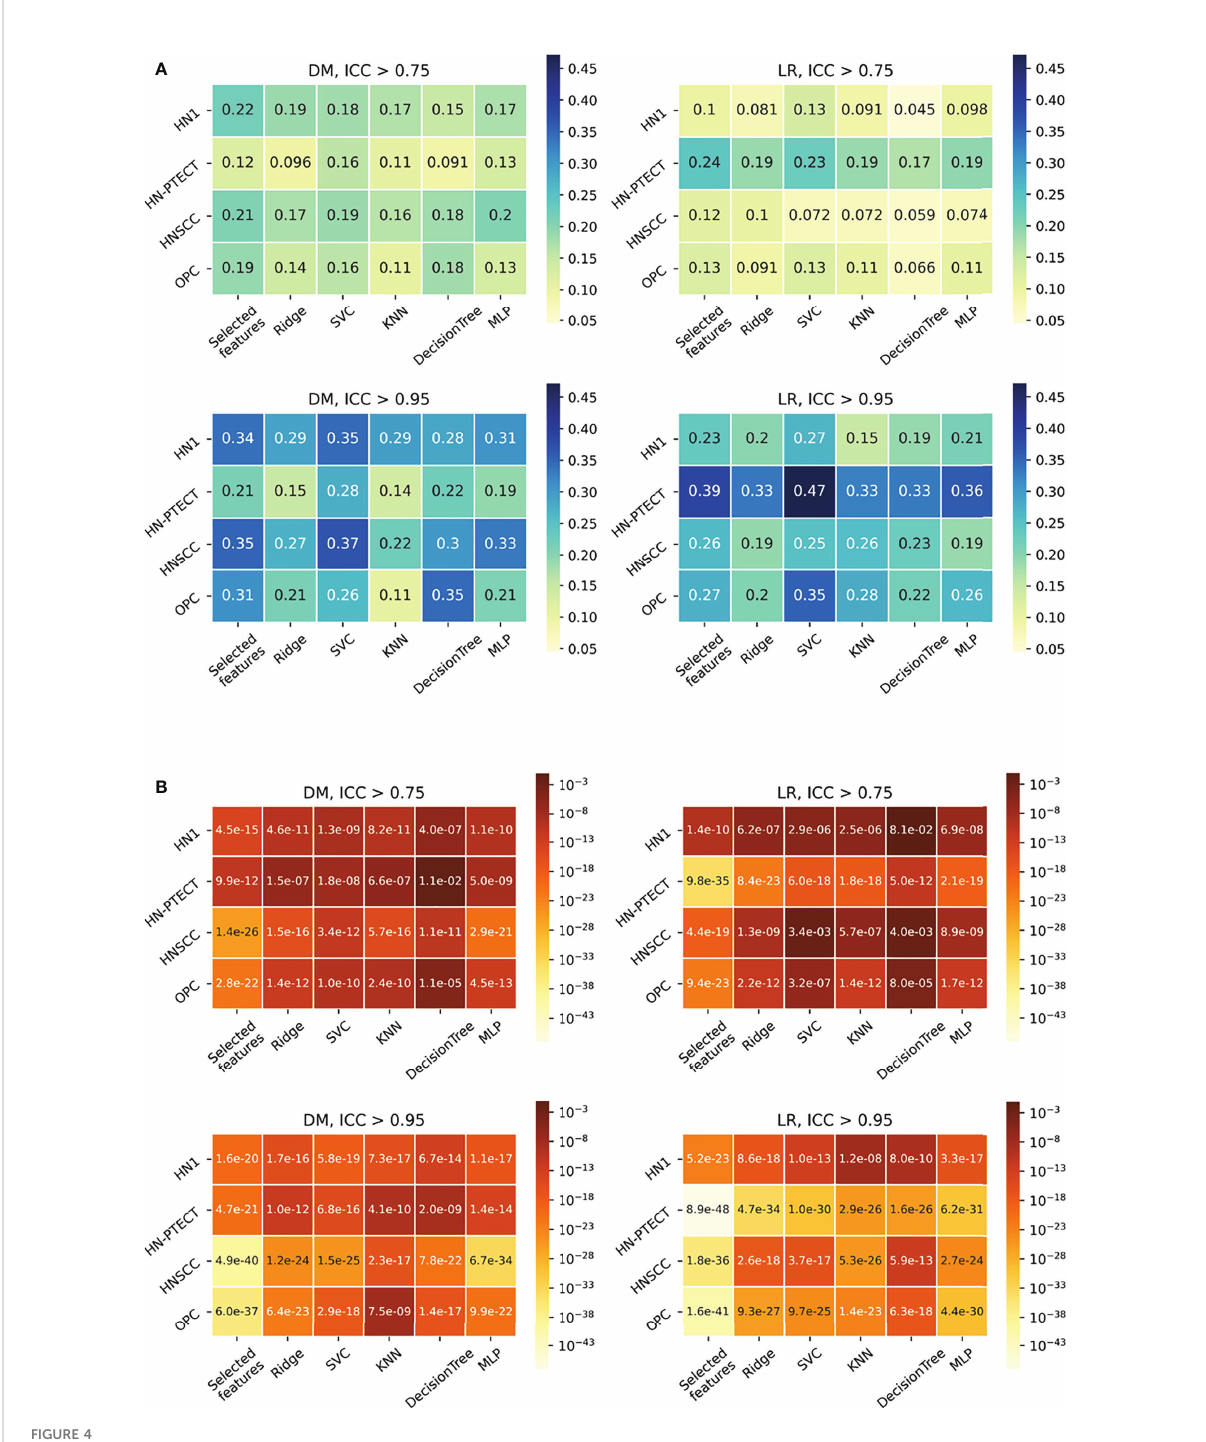
FIGURE 4 Average intraclass correlation coef fi cient (ICC) improvement (A) and t-test P-values (B) of the fi nal selected features and testing predictions after robust feature pre-selection shown in heatmaps. Each heatmap contains the results of one prediction outcome and one feature robustness fi ltering threshold. The fi rst column of each heatmap represents the improvements of the fi nal selected radiomic features, and the remaining fi ve columns are the improvements of the testing prediction robustness using different classi fi ers. Results of the four datasets are recorded in rows. All the experiments showed positive improvements in ICC. A higher and more statistically signi fi cant increase in average ICC improvements can be observed with a higher fi ltering